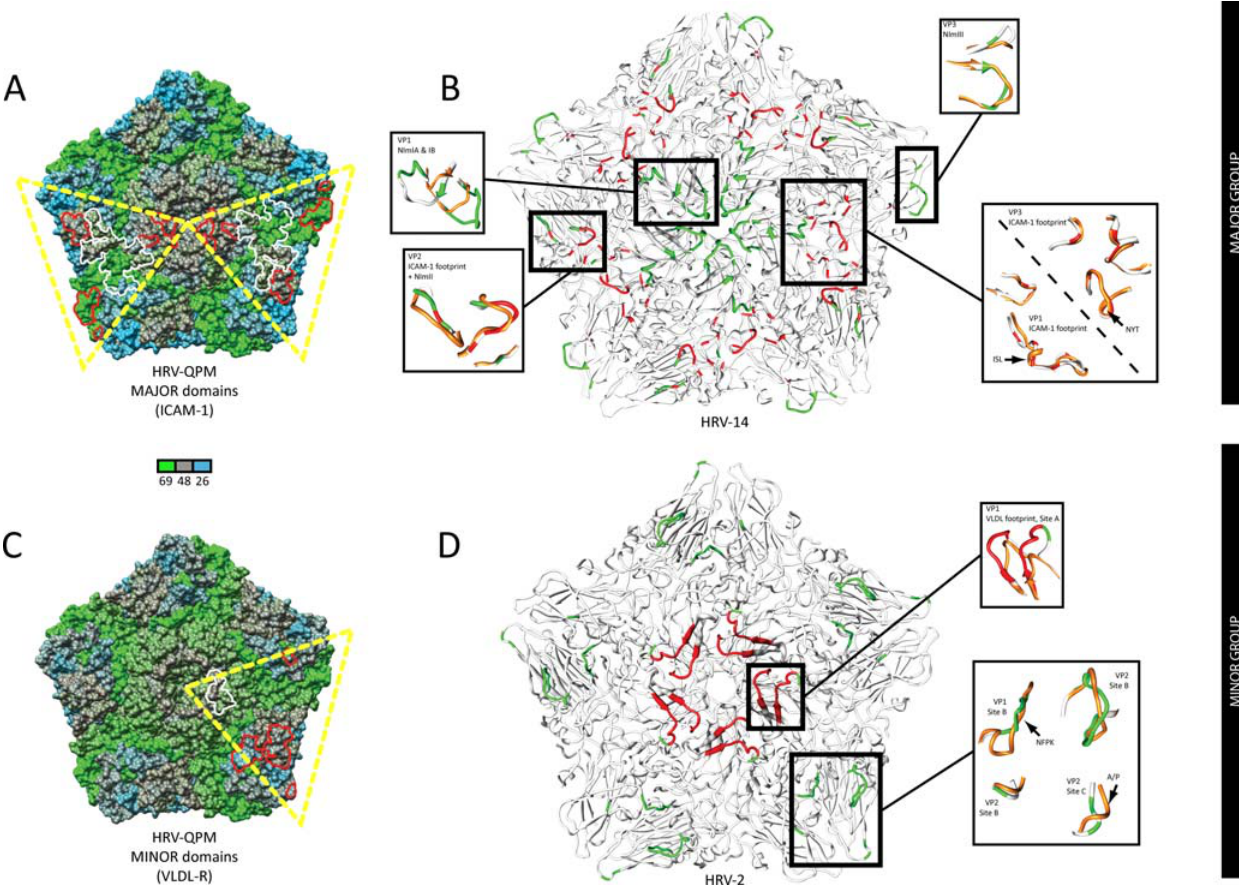
Figure 3. Predicted HRV-QPM pentamers compared to representative major (HRV-14) and minor (HRV-2) group HRV pentamers derived from crystallography data. (A) HRV-QPM versus HRV-14 SimPlot data projected onto a space filling depiction of the predicted HRV-QPM pentamer. Shading represents the amino acid identity (26–69%). The yellow dashed triangle represents a single icosahedral asymmetric unit (T=p3 conformation) composed of VP1 and VP2 from the same protomer and VP3 for an adjacent protomer. The major group domains of interest are divided between two asymmetric units for ease of viewing. Receptor (white) and antigenic (red) sites are shown in outline. (B) Top view ribbon depiction of a major group HRV pentamer (HRV-14; gray) with labelled antigenic neutralisation sites (NImIA-III, green) and combined HRV A (HRV-16) and B (HRV-14)ICAM-1 receptor footprints (red) [6,37]. Magnified areas of interest (boxed) highlight computer-based predictive comparisons to the equivalent HRV-QPM (orange) structures of interest. Arrows indicate structures and corresponding sequences of interest (refer to text). (C) HRV-QPM versus HRV-2 SimPlot data projected onto the HRV-QPM pentamer. The domains of interest are mostly shown within a single asymmetric unit. (D) A minor group pentamer (HRV-2; gray) including antigenic sites (sites A–C, green) and VLDL-R footprint (red) [10]. Attachment of the VLDL-R involves adjacent VP1 molecules. Magnified VP1 area represents one half of a VLDL-R footprint [42]. Amino acid substitutions (arrowed) contributed to the differences between minor group sites B and C.